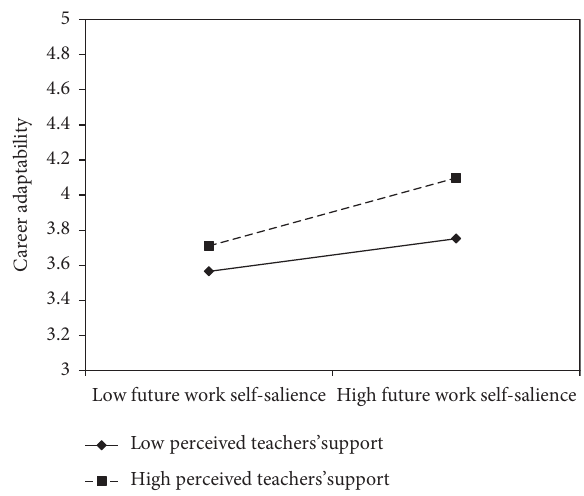
Figure 4: The effect of the interaction between future work self- salience and perceived teacher support on career